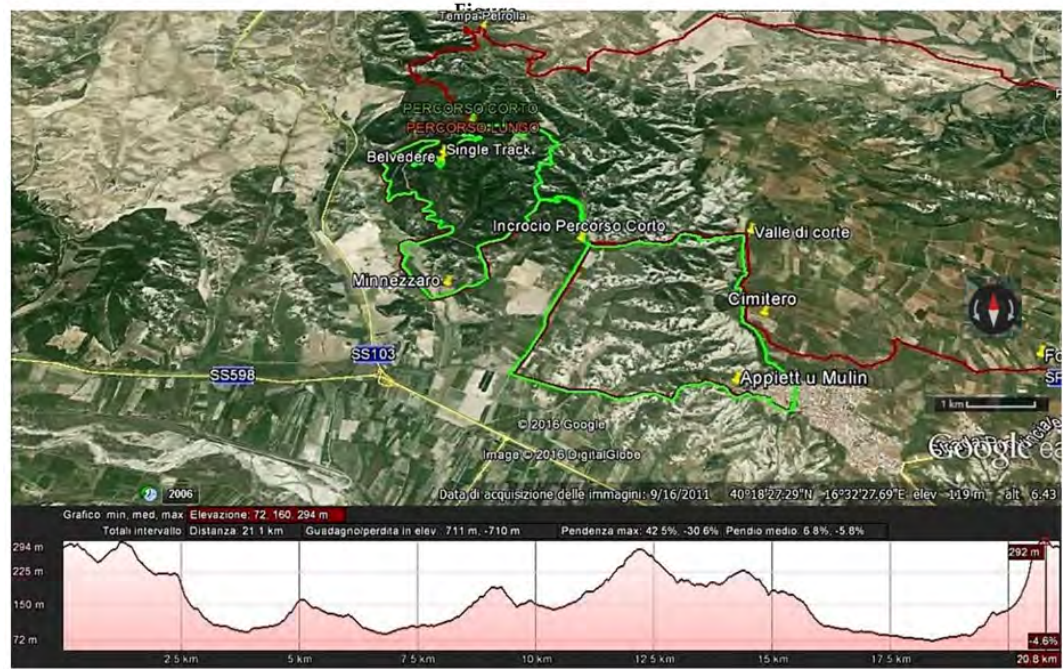
Figure 7. The Calanchi bike marathon track (courtesy of the organizing committee).